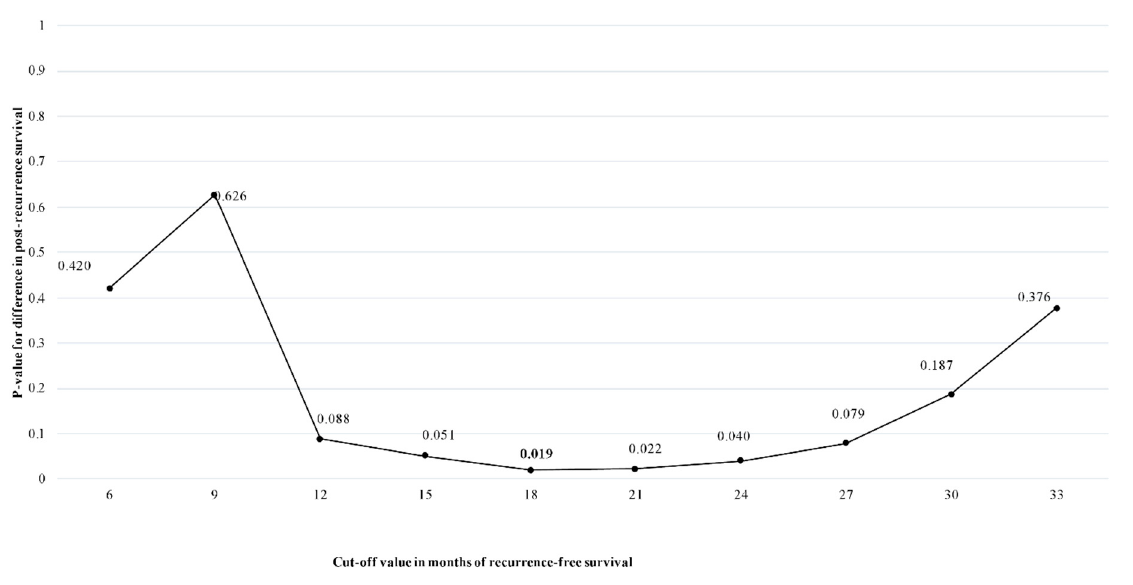
Figure 1. The cut-off value in months of RFS determined by difference in PRS for patients with a pNET.